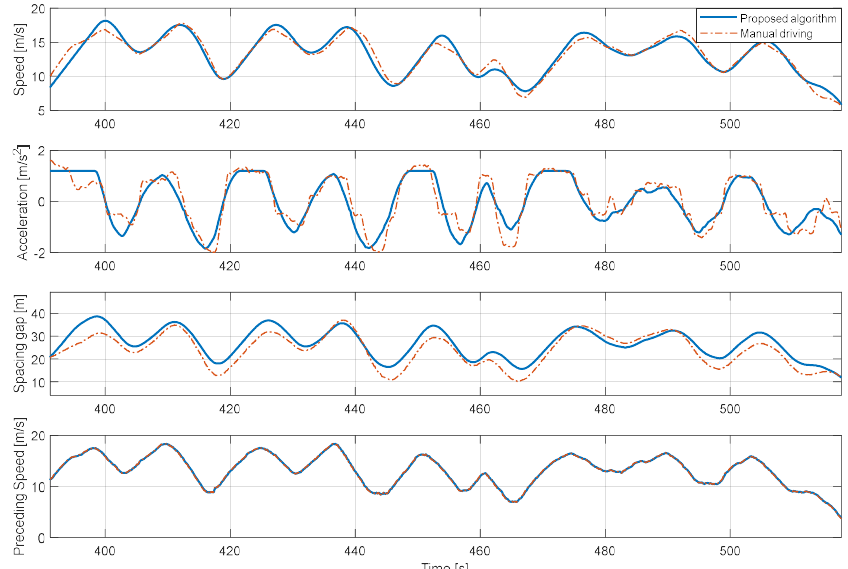
Figure 10. Comparison of 1st driver’s real-driving data and simulation results of the proposed algorithm with 1st driver model.